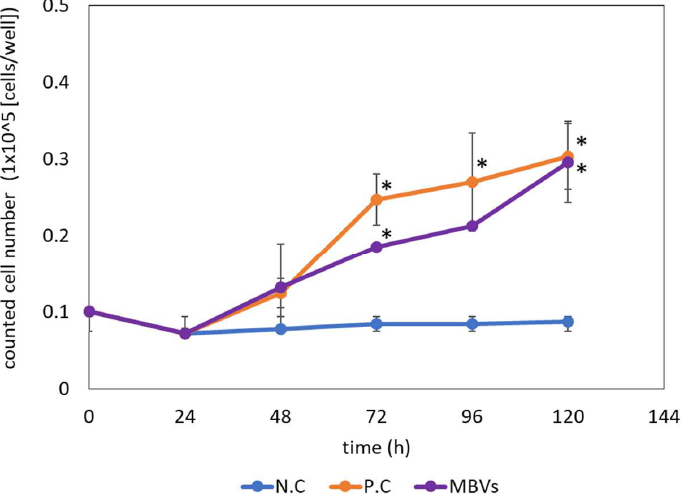
Figure 8. Growth curve of HH cells exposed to isolated MBVs derived from HHP-decellularized SIS. * p < 0.05.